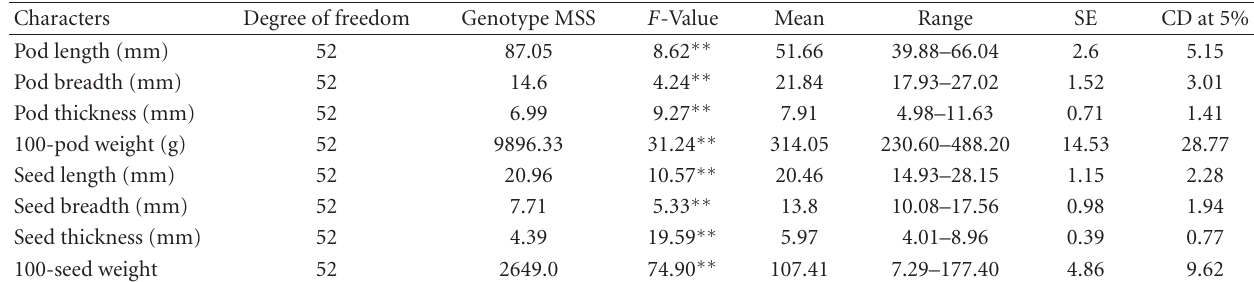
Table 3: Analysis of variance and phenotypic variability of pod and seed characters of P. pinnata